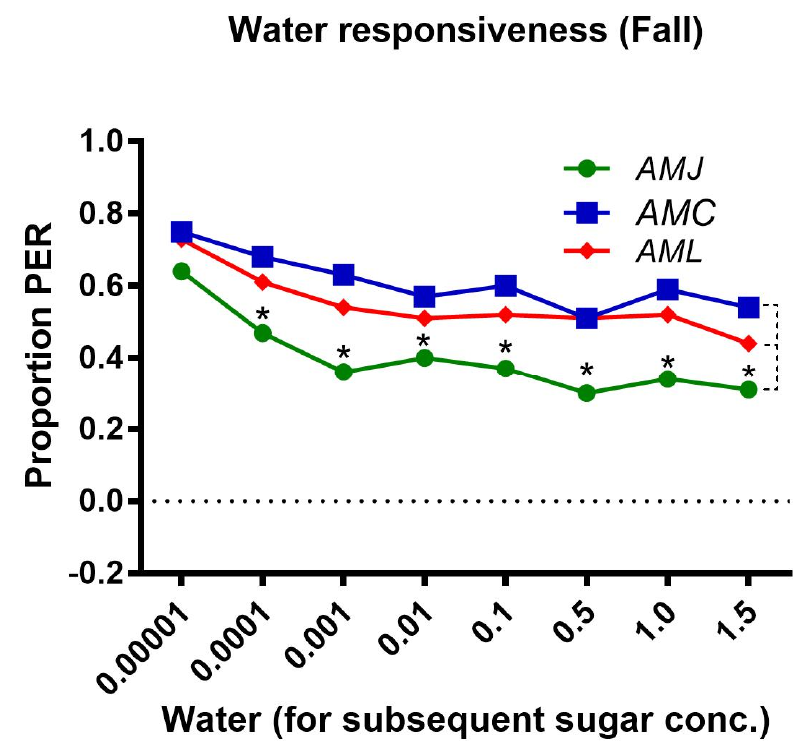
Figure 6. Water responsiveness, i.e., response of bees to water tested prior to the PER test to each sugar concentration. Asterisks indicate the significant difference ( x 2 or Fisher’s exact test * p < 0.05) among the water responses of honey bee subspecies ( AMJ , AMC and AML ).